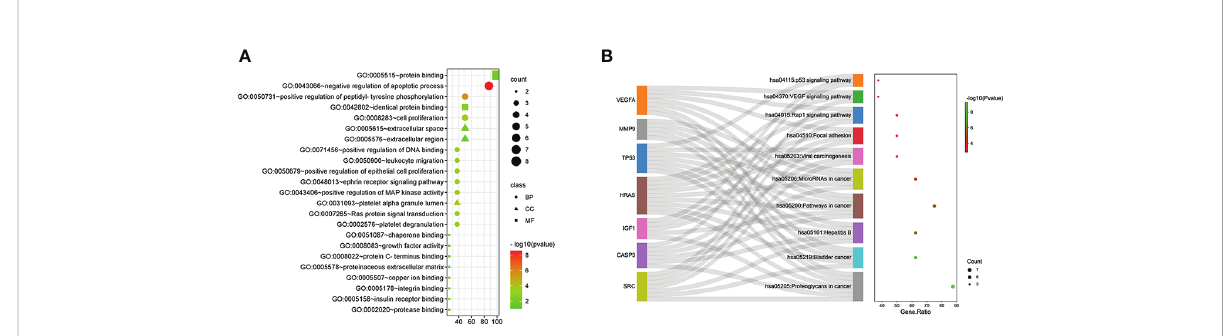
FIGURE 3 Gene Ontology (GO) and Kyoto Encyclopedia of Genes and Genomes (KEGG) pathway analyses of hub genes. (A) GO analysis. (B) KEGG pathway